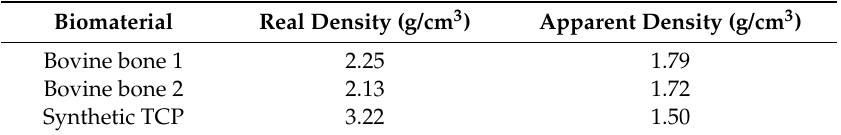
Table 2. Real density measured by helium pycnometry and apparent density measured by mercury porosimetry.